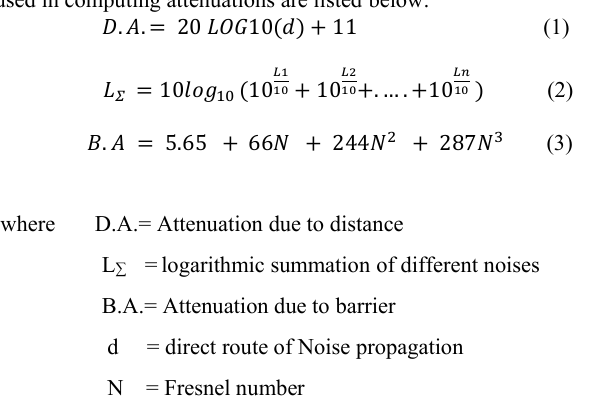
Figure 3. Noise level map of Hazartganj Intersection at morning time using NoiseCapture app scaled with standard SPL